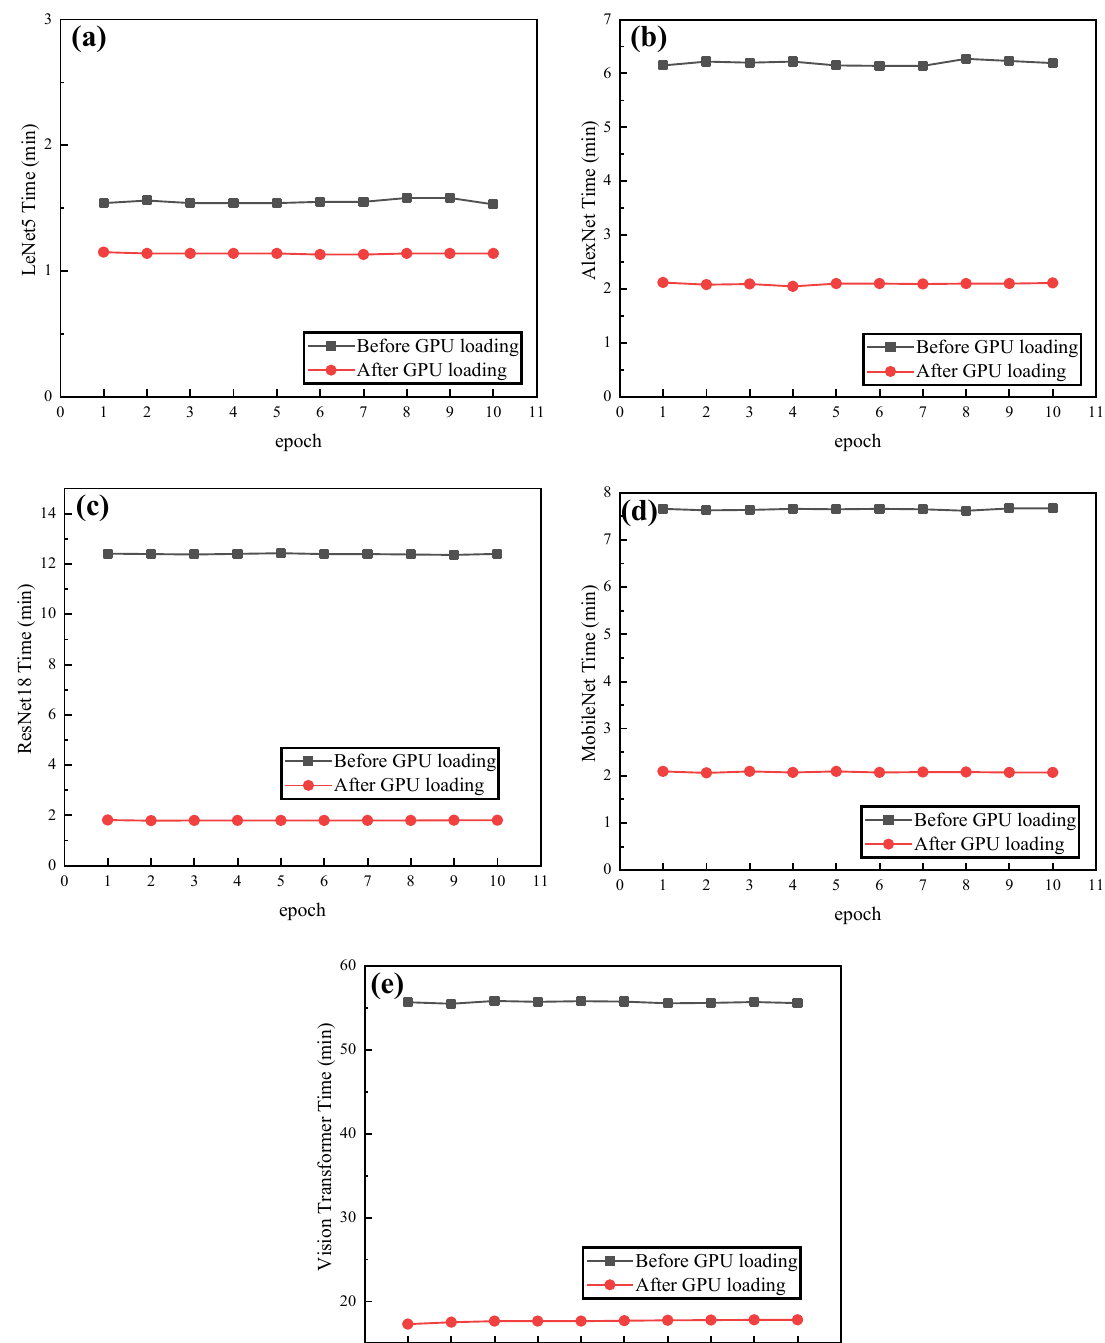
Figure 11. Comparison of the efficiency of each model after data augmentation before and after GPU loading. ( a ) Comparison of the efficiency of LeNet5 model. ( b ) Comparison of the efficiency of AlexNet model. ( c ) Comparison of the efficiency of ResNet18 model. ( d ) Comparison of the efficiency of MobileNet model. ( e ) Comparison of the efficiency of Vision Transformer